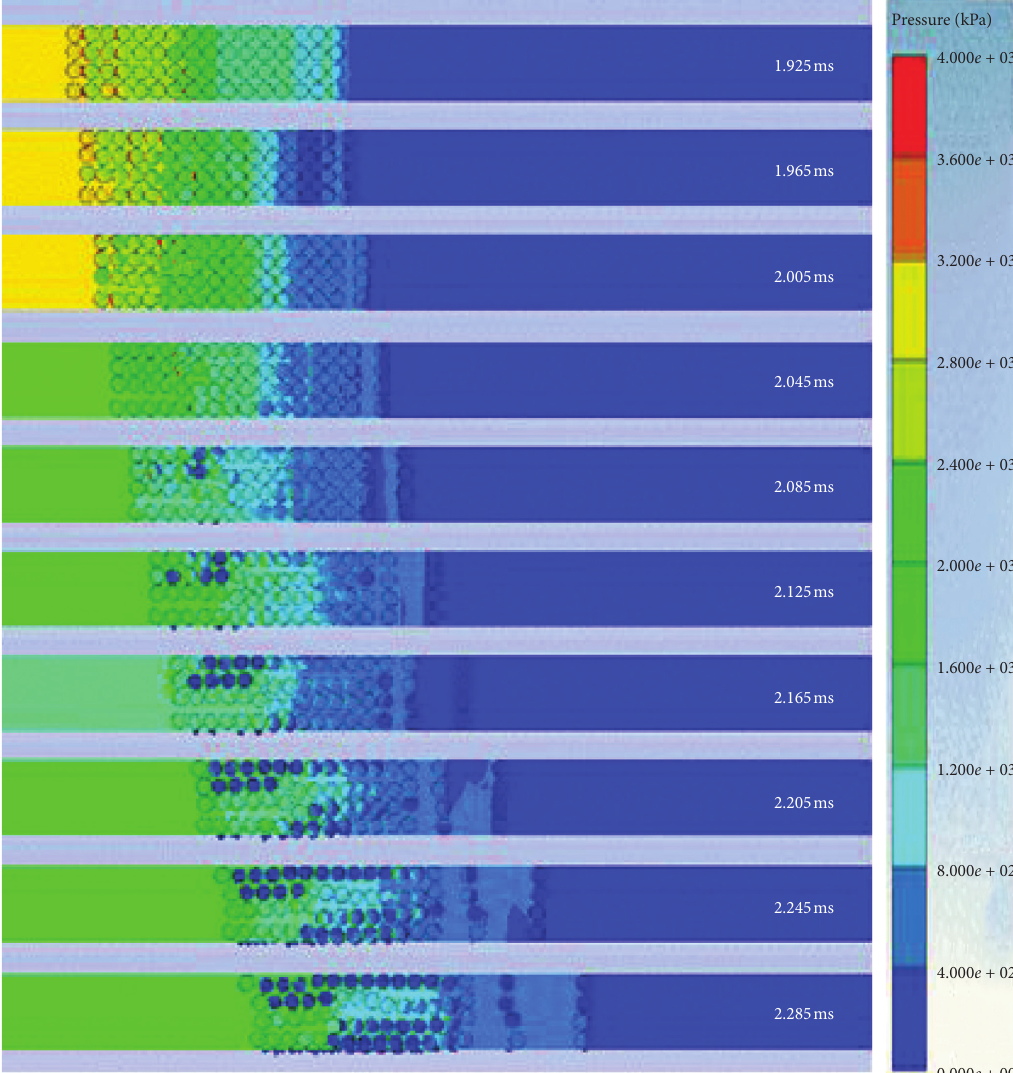
Figure 14: Gas pressure gradient among the particle